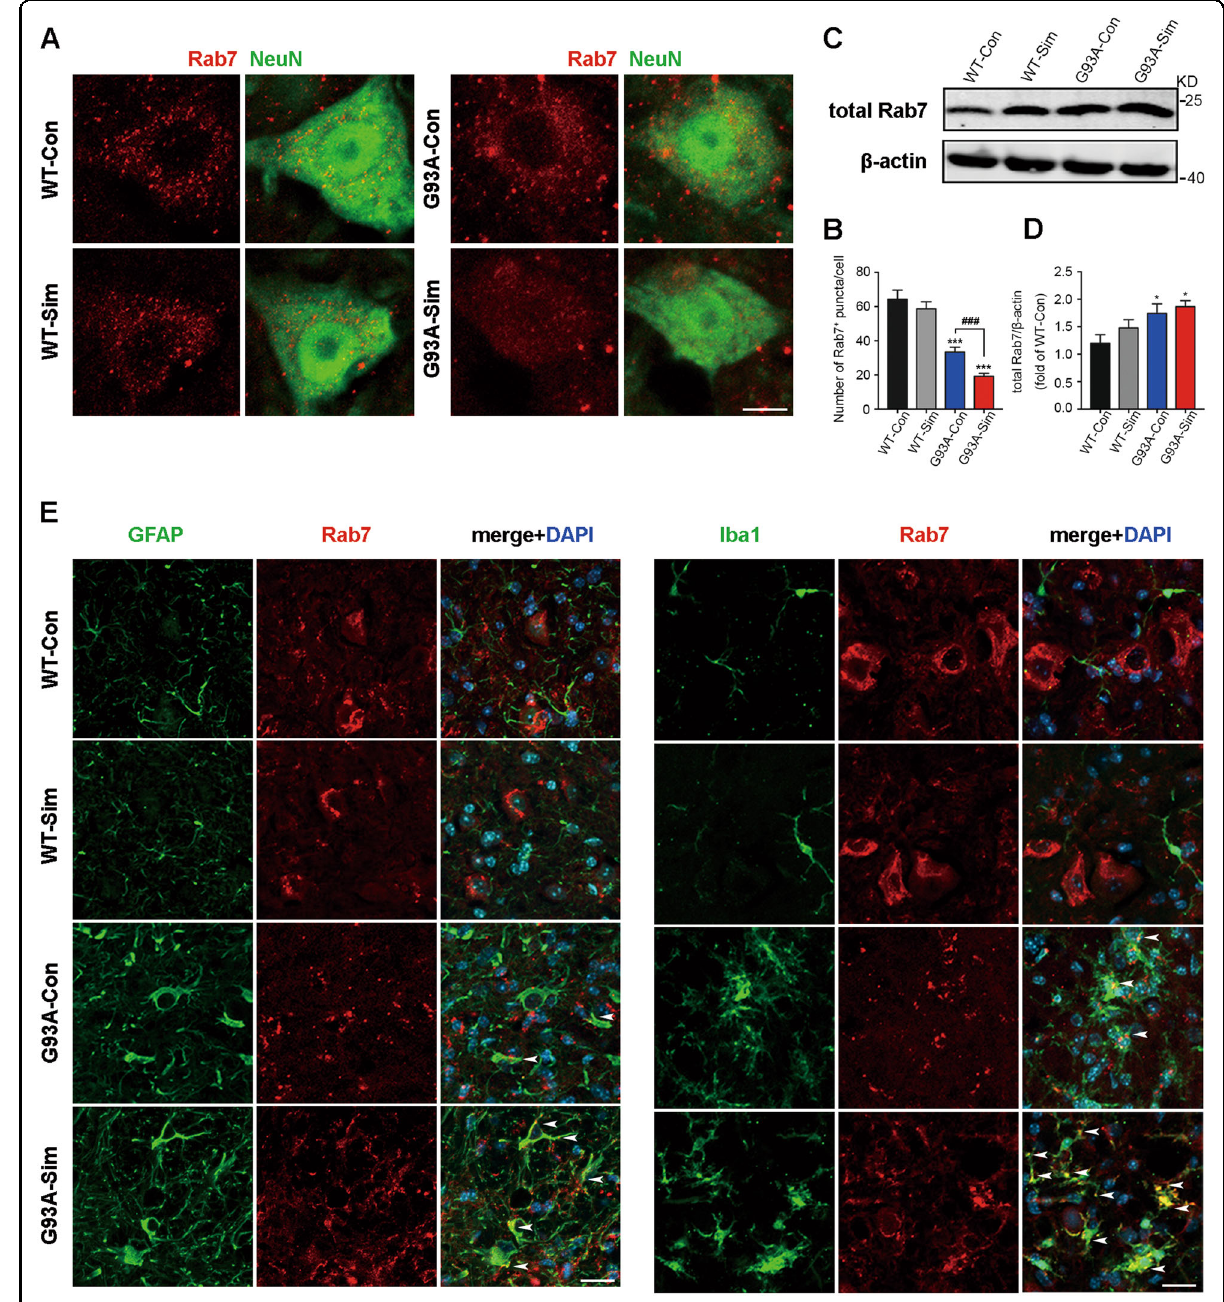
Fig. 5 Simvastatin blocked Rab7 localization to membranes in MNs from SOD1 G93A mice. A Immuno fl uorescence labeling of Rab7 (red) in NeuN-positive motoneurons (green) at 120 days (Scale bars, 10 μ m). B Quantitative analysis of Rab7-positive puncta. C Western blot analysis of total Rab7 in the lumbar spinal cord at 120 days. D Quanti fi cation of total Rab7 levels. E Immunostaining of Rab7 (red) and GFAP (green), Rab7 (red) and Iba1 (green) in the lumbar spinal cord at 120 days (Scale bars, 20 μ m). Nuclei were stained with DAPI (blue). White arrowheads show the portions of GFAP + /Rab7 + and Iba1 + /Rab7 + , respectively. (Data represent the mean ± SEM, n = 5 mice per group; statistical signi fi cance was assessed by one- way ANOVA or an unpaired t -test, * P ≤ 0.05, ** P ≤ 0.01, *** P ≤ 0.001, # P ≤ 0.05, ## P ≤ 0.01, ### P ≤